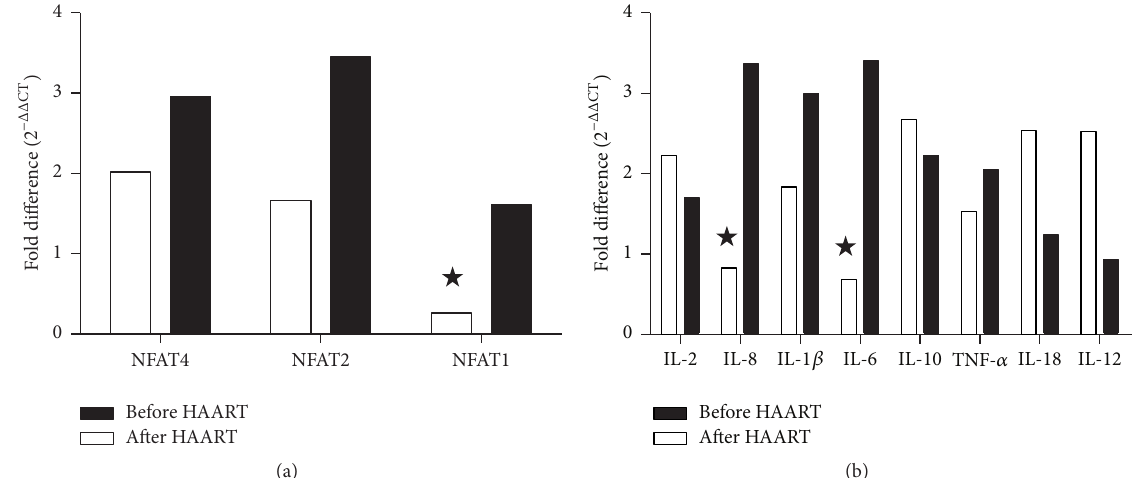
Figure2:NFATandcytokinegenerelativeexpressionlevelscomparingtheIRIStonon-IRISgroupsofAIDSpatientsbeforeandafterHAART. (a) NFAT expression in IRIS and non-IRIS groups before HAART. NFAT1 expression was obviously lower in IRIS group. (b) Cytokine gene expression in IRIS and non-IRIS groups before HAART. IL-6 and IL-8 expressions were obviously lower in IRIS group; ‰ before HAART, the gene expressions in IRIS group were lower than those in non-IRIS